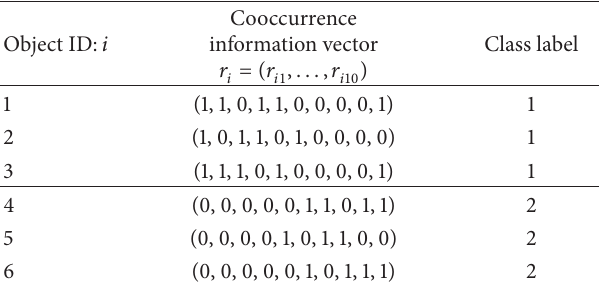
Table 1: A toy example of supervised objects